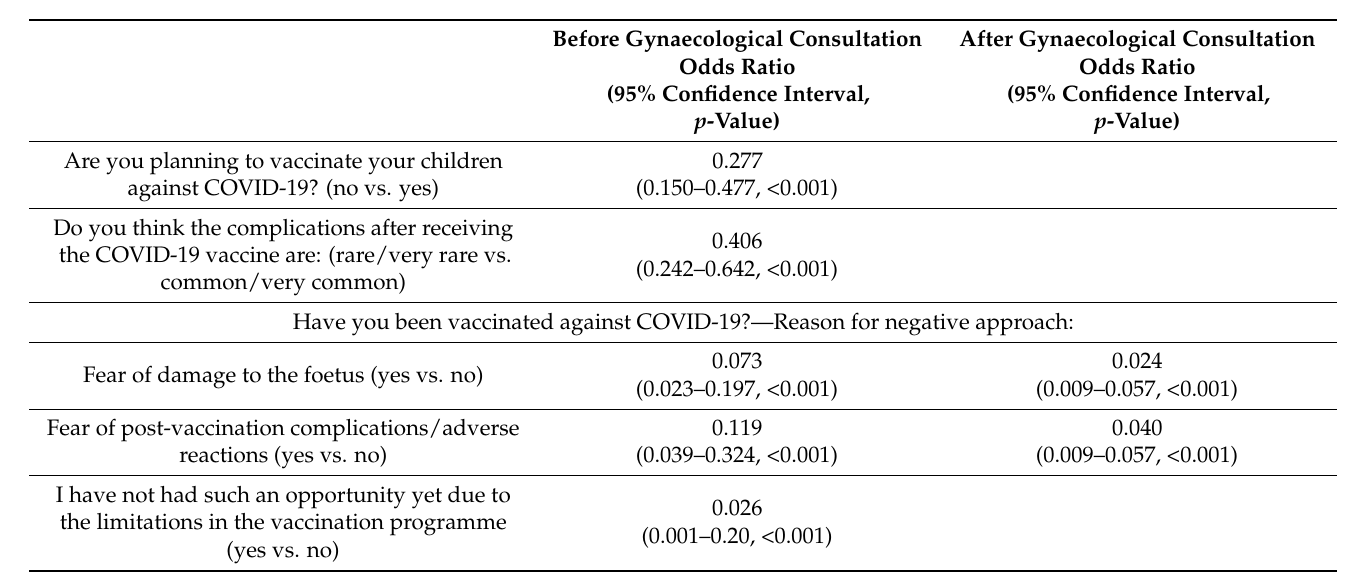
Table 1. Predictors of vaccination against COVID-19 before and after gynaecological consultation assessed by multivariate